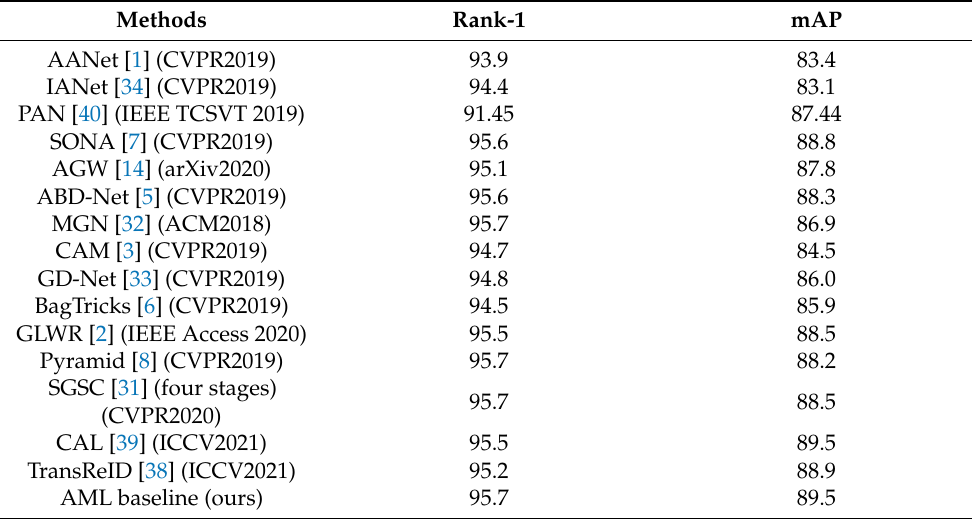
Table 4. Comparison of advanced baselines on